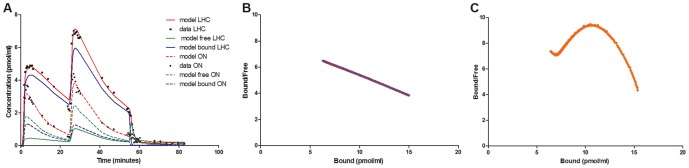
Kinetic curves from the multi-injection study and subsequent data simulations.(A) Individual data points for the left hippocampus (black squares) and the olive nucleus (black circles) are plotted, with the solid lines showing the model fit in the left hippocampus, and dashed lines the model fit in the olive nucleus. Red lines show total [18F]-FMZ uptake as estimated by the model, blue lines the amount of specific [18F]-FMZ binding, and the green lines the amount of free [18F]-FMZ in the tissue. (B) Scatchard plot for parameter estimates of the hippocampus using the true free fraction for the hippocampus. (C) Scatchard plot for parameter estimates of the hippocampus using the reference region (olive nucleus).